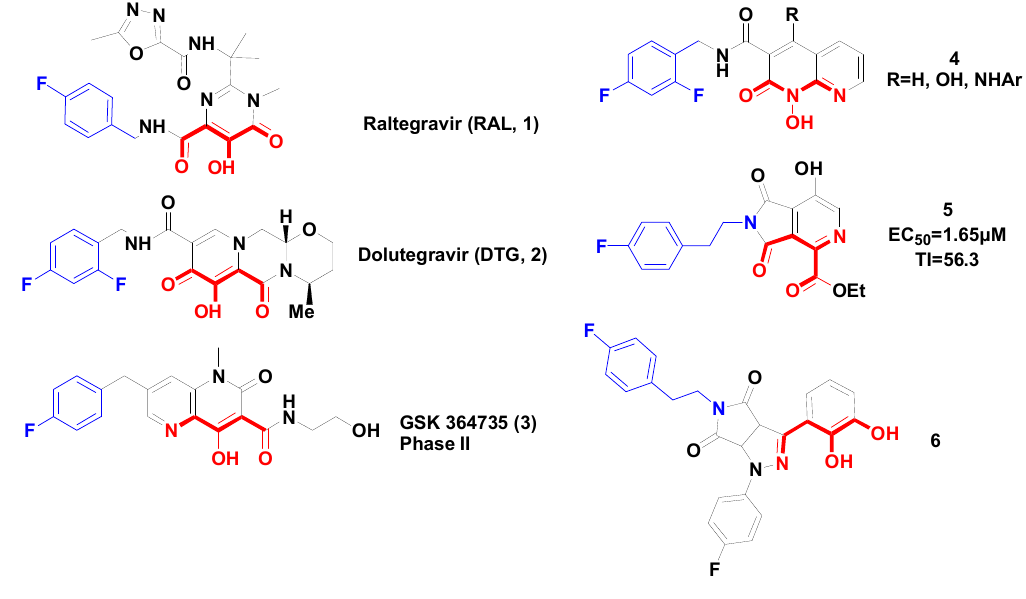
Figure 1. HIV-1 integrase inhibitors.